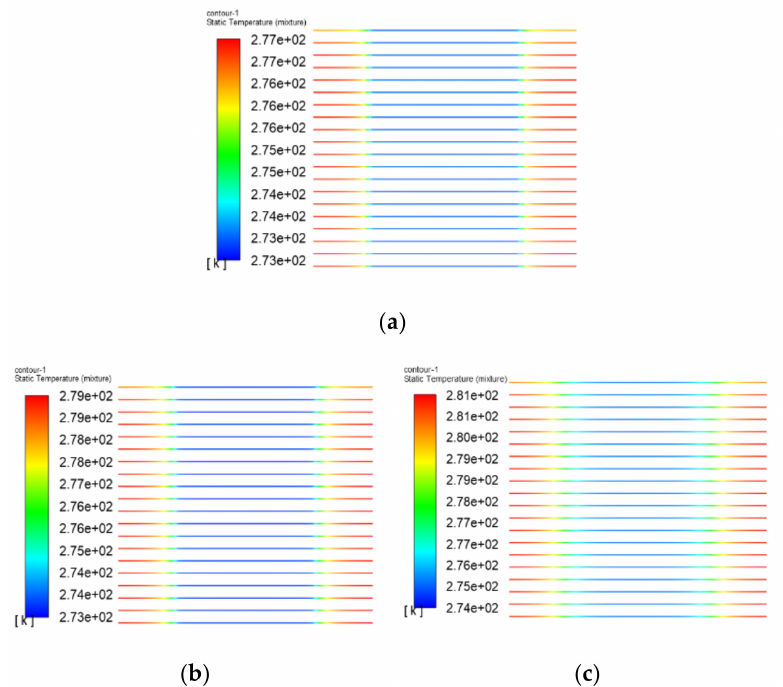
Figure 10. Temperature contours of the PEM at di ff erent times; ( a ) t = 24 s, ( b ) t = 28 s, ( c ) t = 32